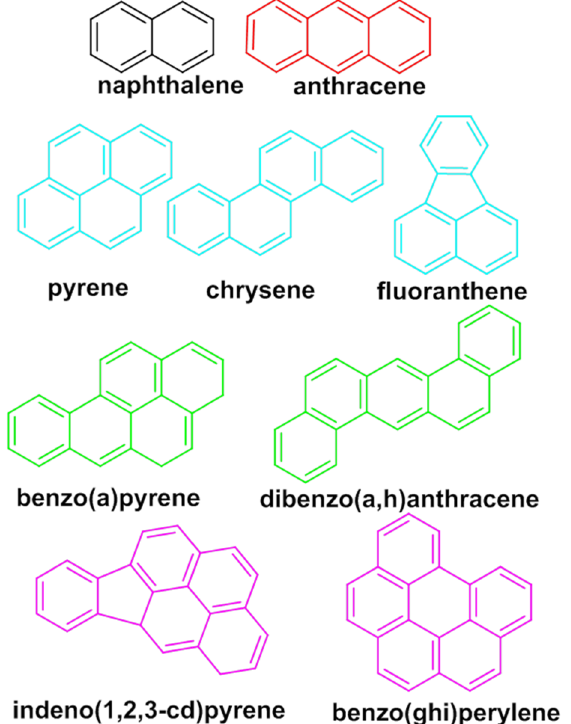
Figure 2. Structure of polycyclic aromatic hydrocarbons (PAHs) present in the environment as pollutants. Solubility (mg/mL): naphthalene, 31.7; anthracene, 0.07; pyrene, 0.14; chrysene, 0.0006; fluoranthene, 0.26; benzo(a)pyrene, 0.003; dibenzo(a,h)anthracene, 0.0005; indeno(1,2,3-cd)pyrene, 0.062; and benzo(ghi)perylene, 0.062.